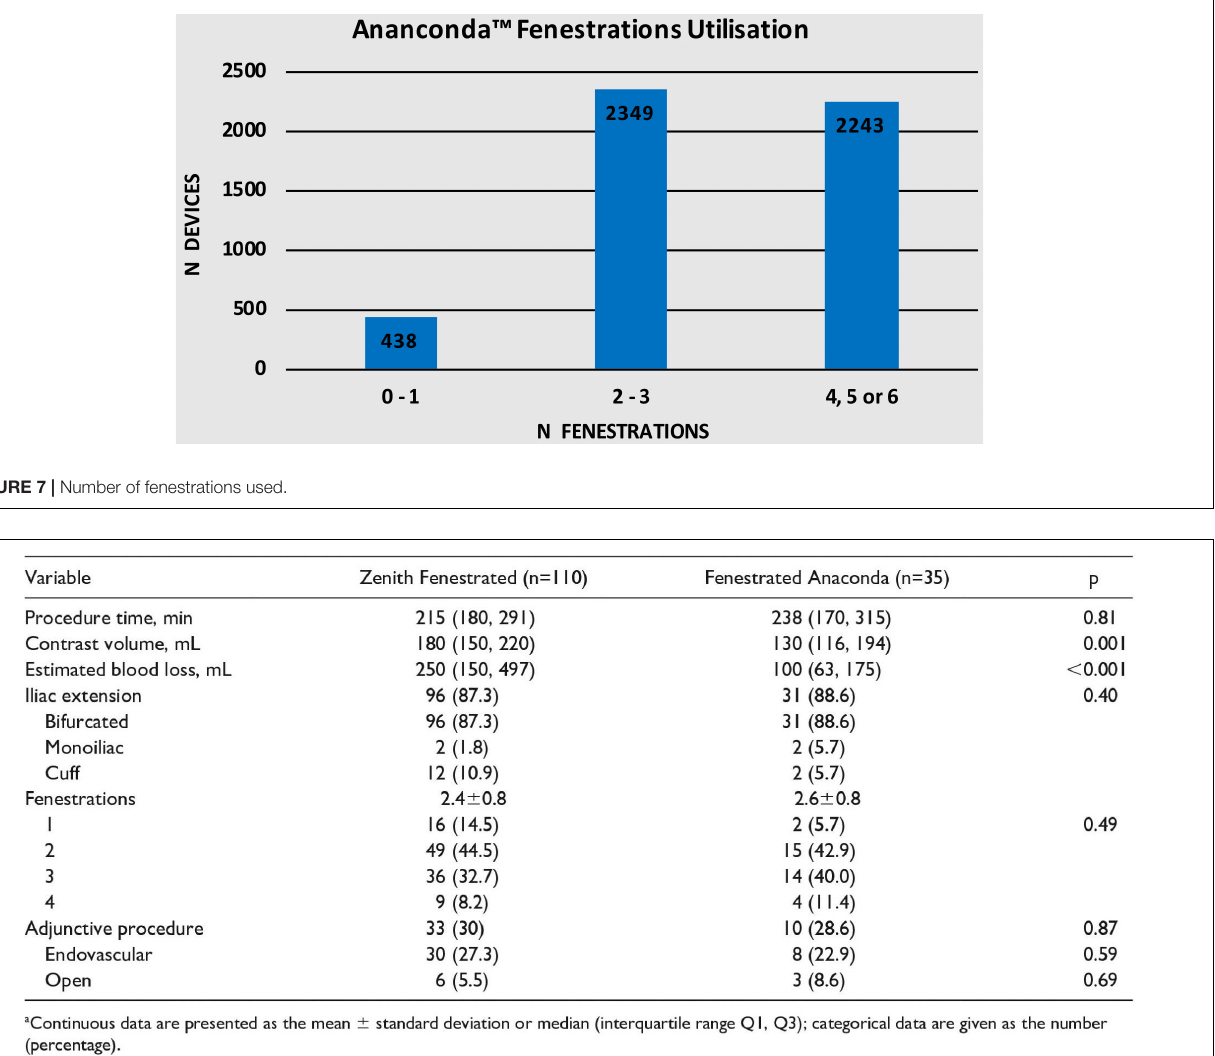
Frontiers in Cardiovascular Medicine |